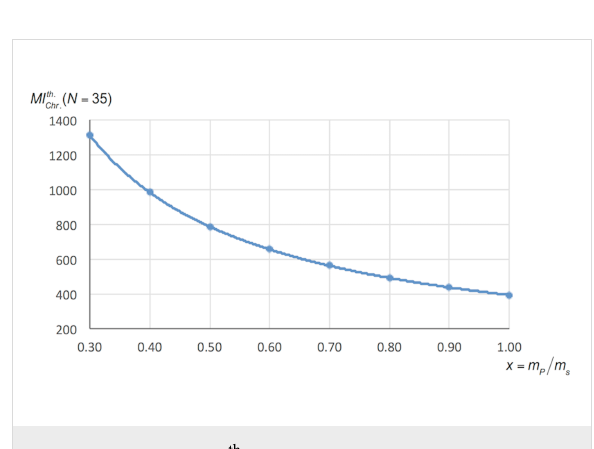
Figure 2: Variation of with x for reaction b (Scheme